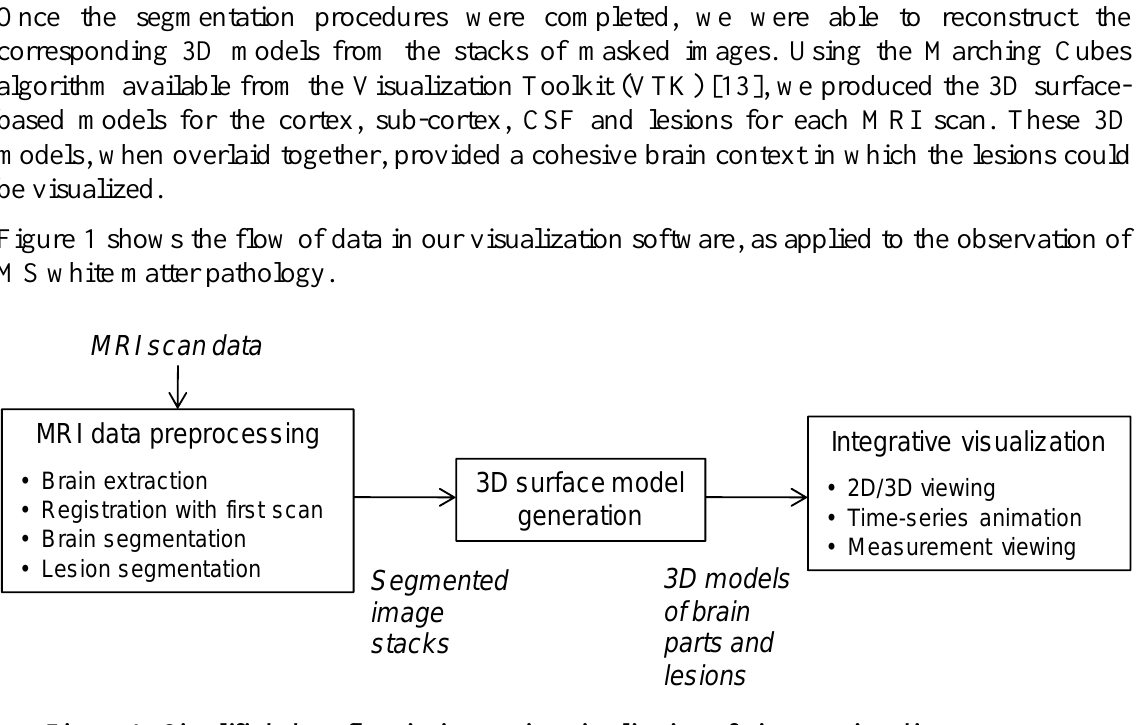
Figure 1: Simplified data flow in integrative visualization of time-varying disease patterns. Multiple scans of the same patient are done at different time points to observe the changes over time through the time-series